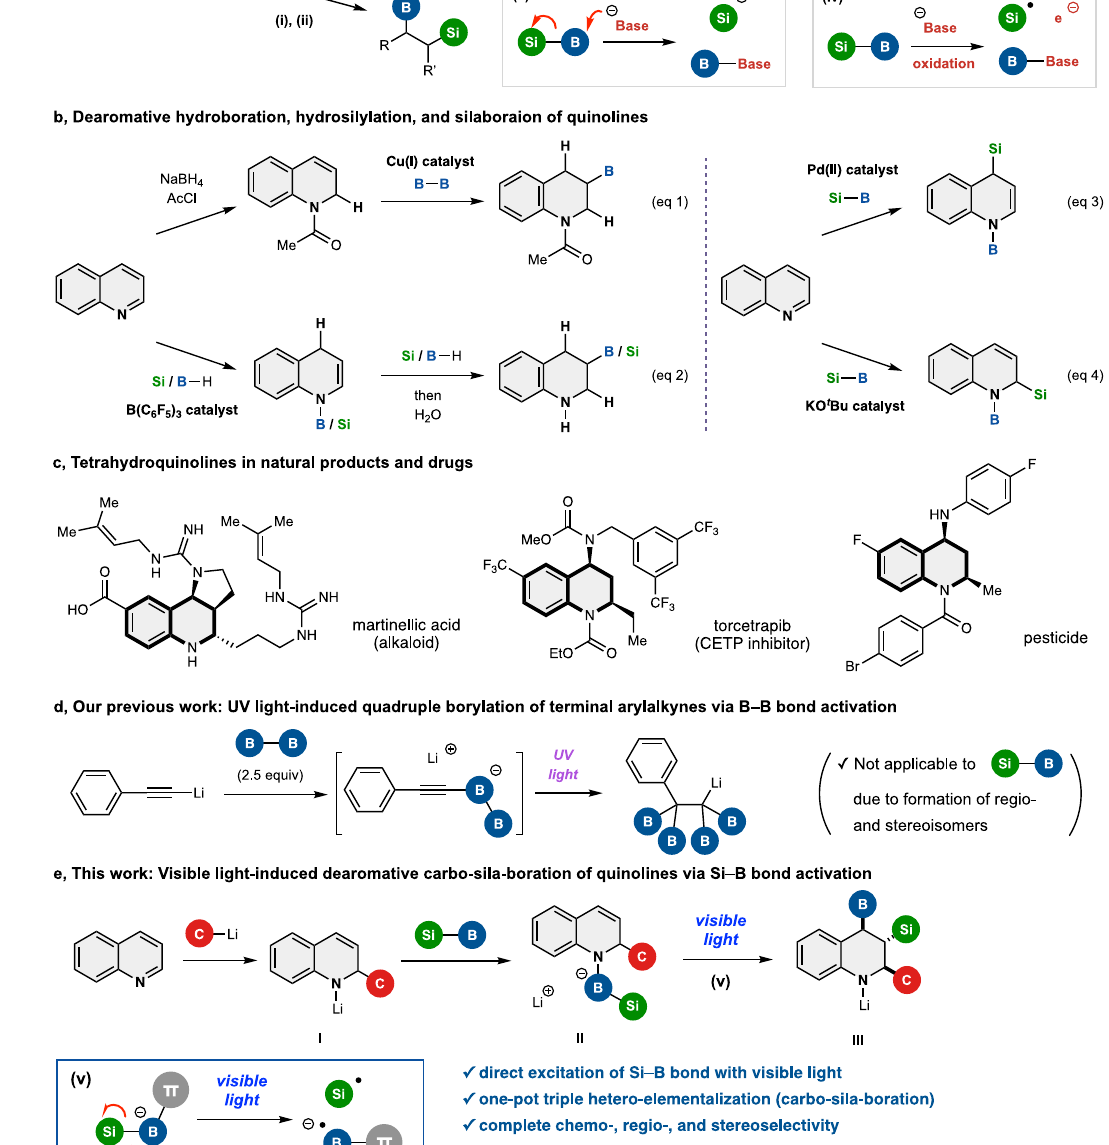
bond-forming silaboration of quinolines. c 1,2,3,4-Tetrahydroquinoline natural products and drugs. d Our previous work: quadruple borylation. e This work: dearomative triple elementalization